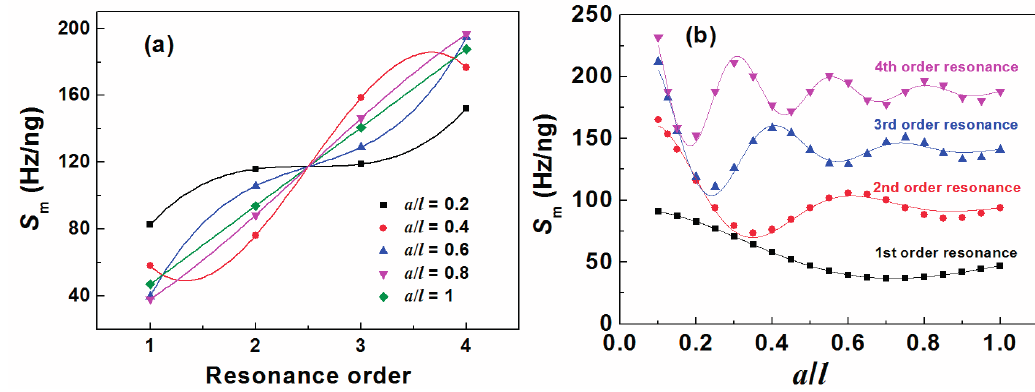
Figure 5. Mass sensitivity ( S m ) as the function of ( a ) resonance order; ( b ) mass